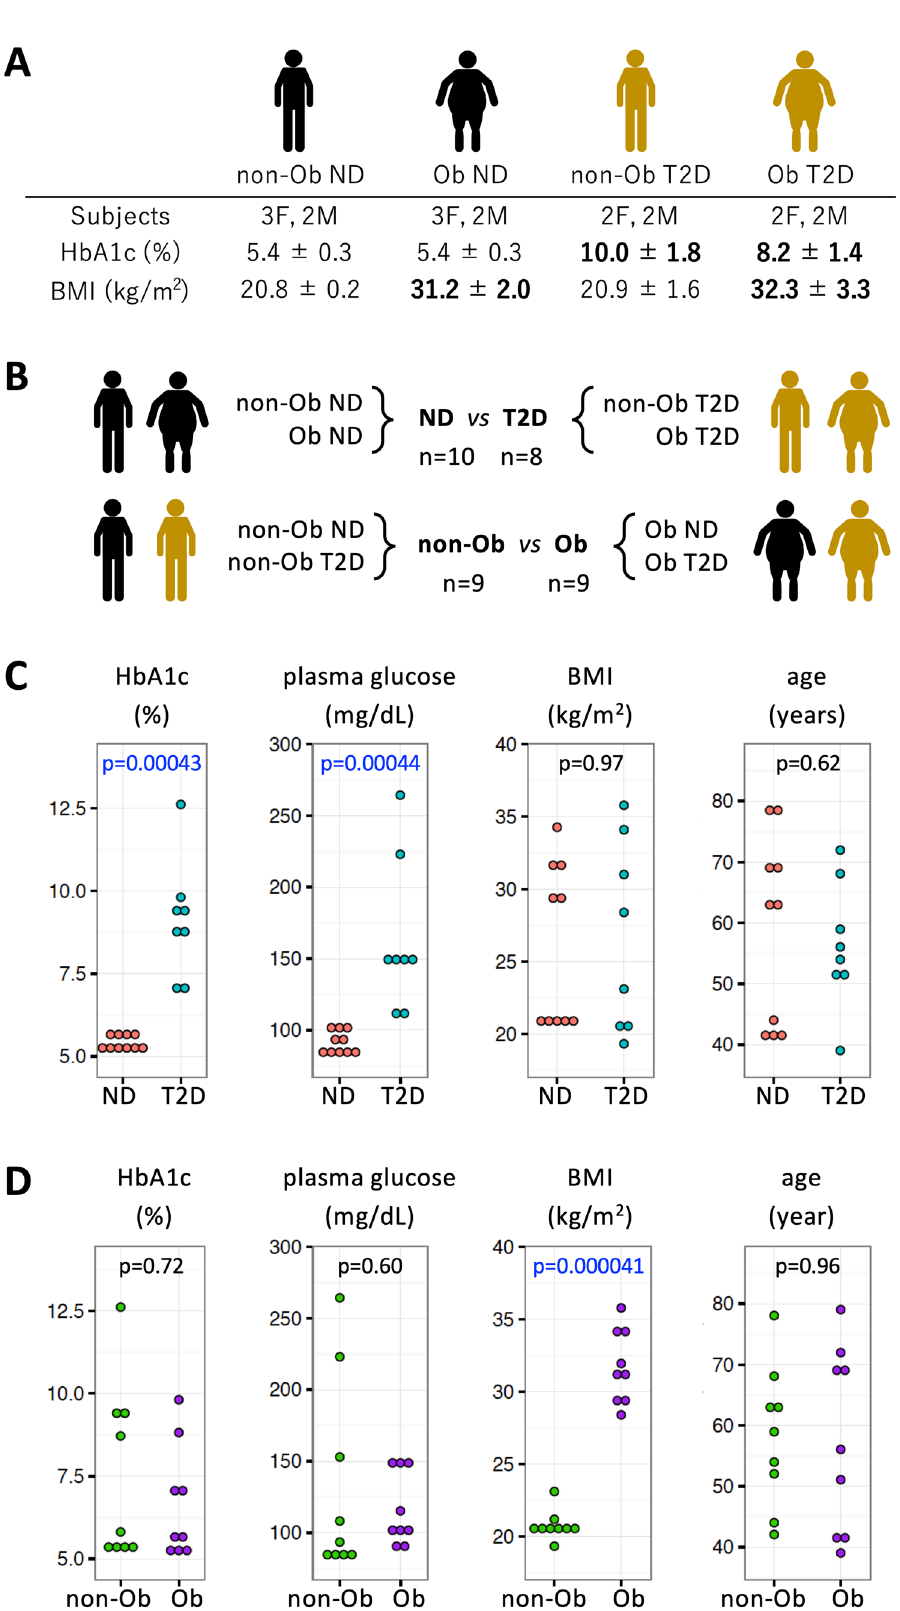
Figure 1. Characteristics and classification of 18 subjects. ( A ) Subjects were divided into four groups based on their HbA1c levels and BMI. Gender composition, mean ± SD of HbA1c, and BMI for each group are shown. ( B ) Group composition of non-diabetic (ND), T2D, non-obese (non-Ob), and obese (Ob) groups. ( C,D ) Graphic presentations of HbA1c, plasma glucose, BMI, and age in ND vs T2D ( C ) and non-Ob vs Ob ( D ). In each panel, p-values are presented to show the significance of differences. P-values less than 0.05 are highlighted in